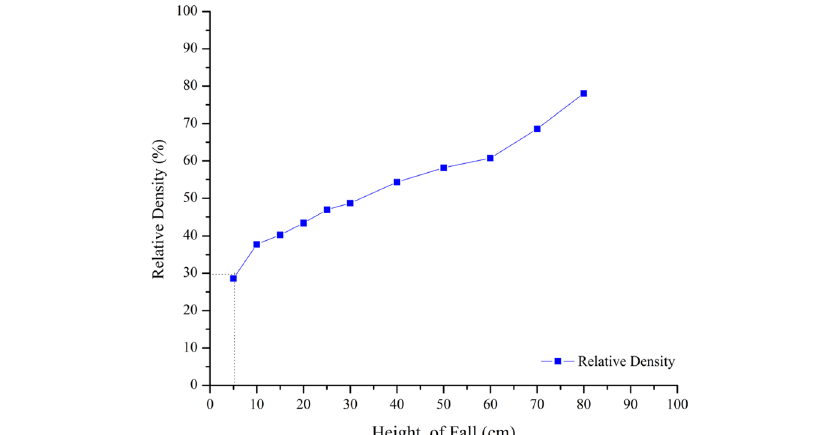
Fig. 3 Calibration of sand raining